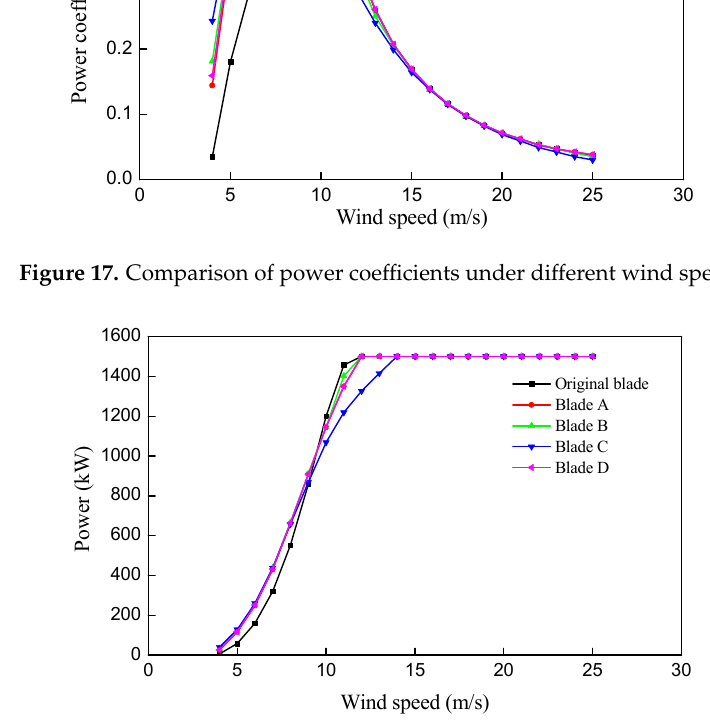
Figure 18. Comparison of powers under different wind speed.